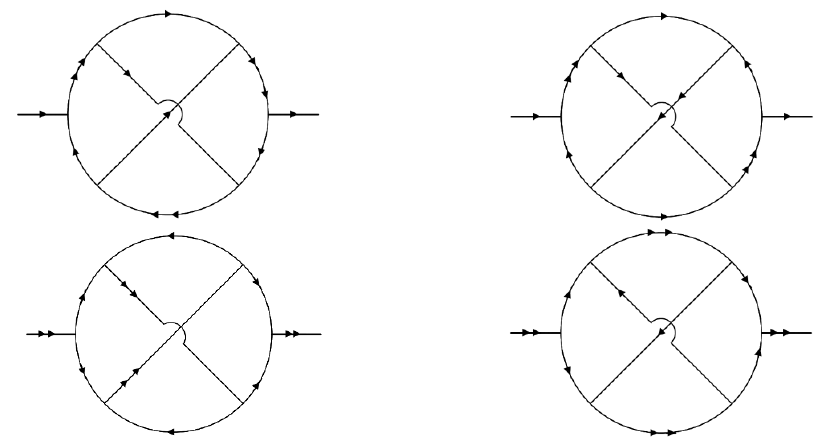
Figure 8. Non-trivial three-loop corrections to the self-energies. We depict all possible assignments of arrows in the lines.